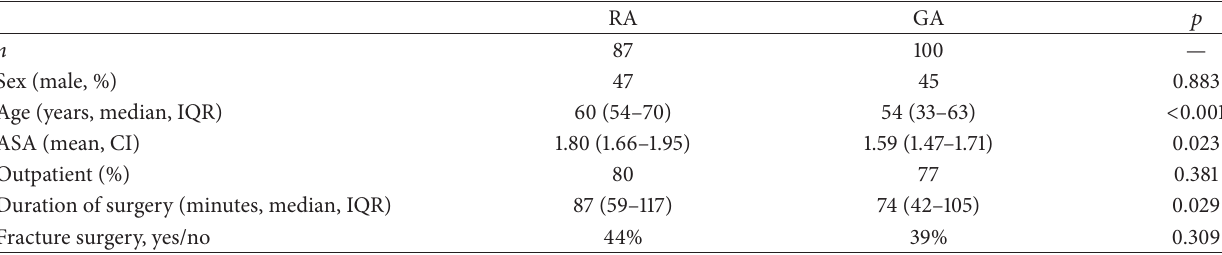
Figure 1: CONSORT-diagram illustrating the study. The 8 patients with failed RA that needed unplanned general anaesthesia was still included in the RA group for an intention to treat analysis. Table 1: Demographics and study variables in the two groups.